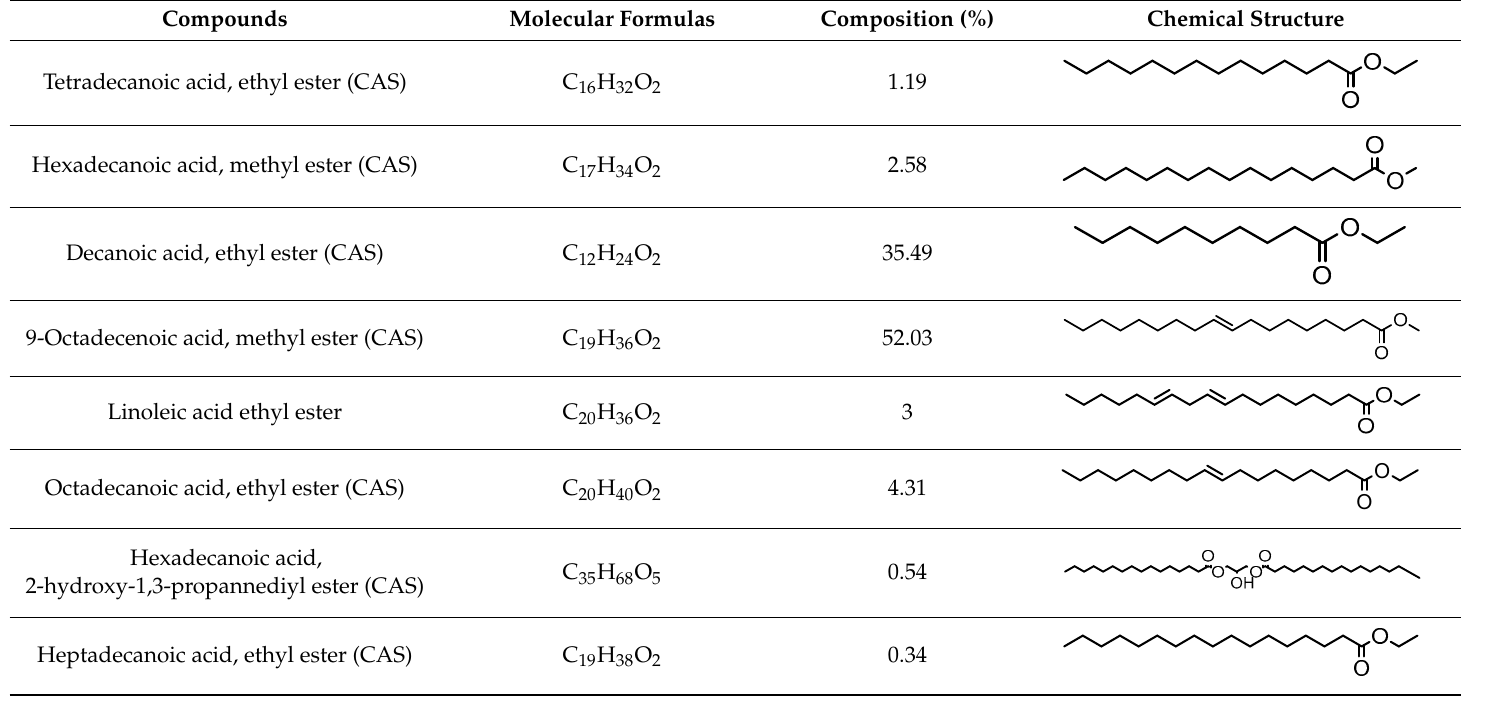
Table 6. The results of the GCMS analysis of biodiesel products. Compounds